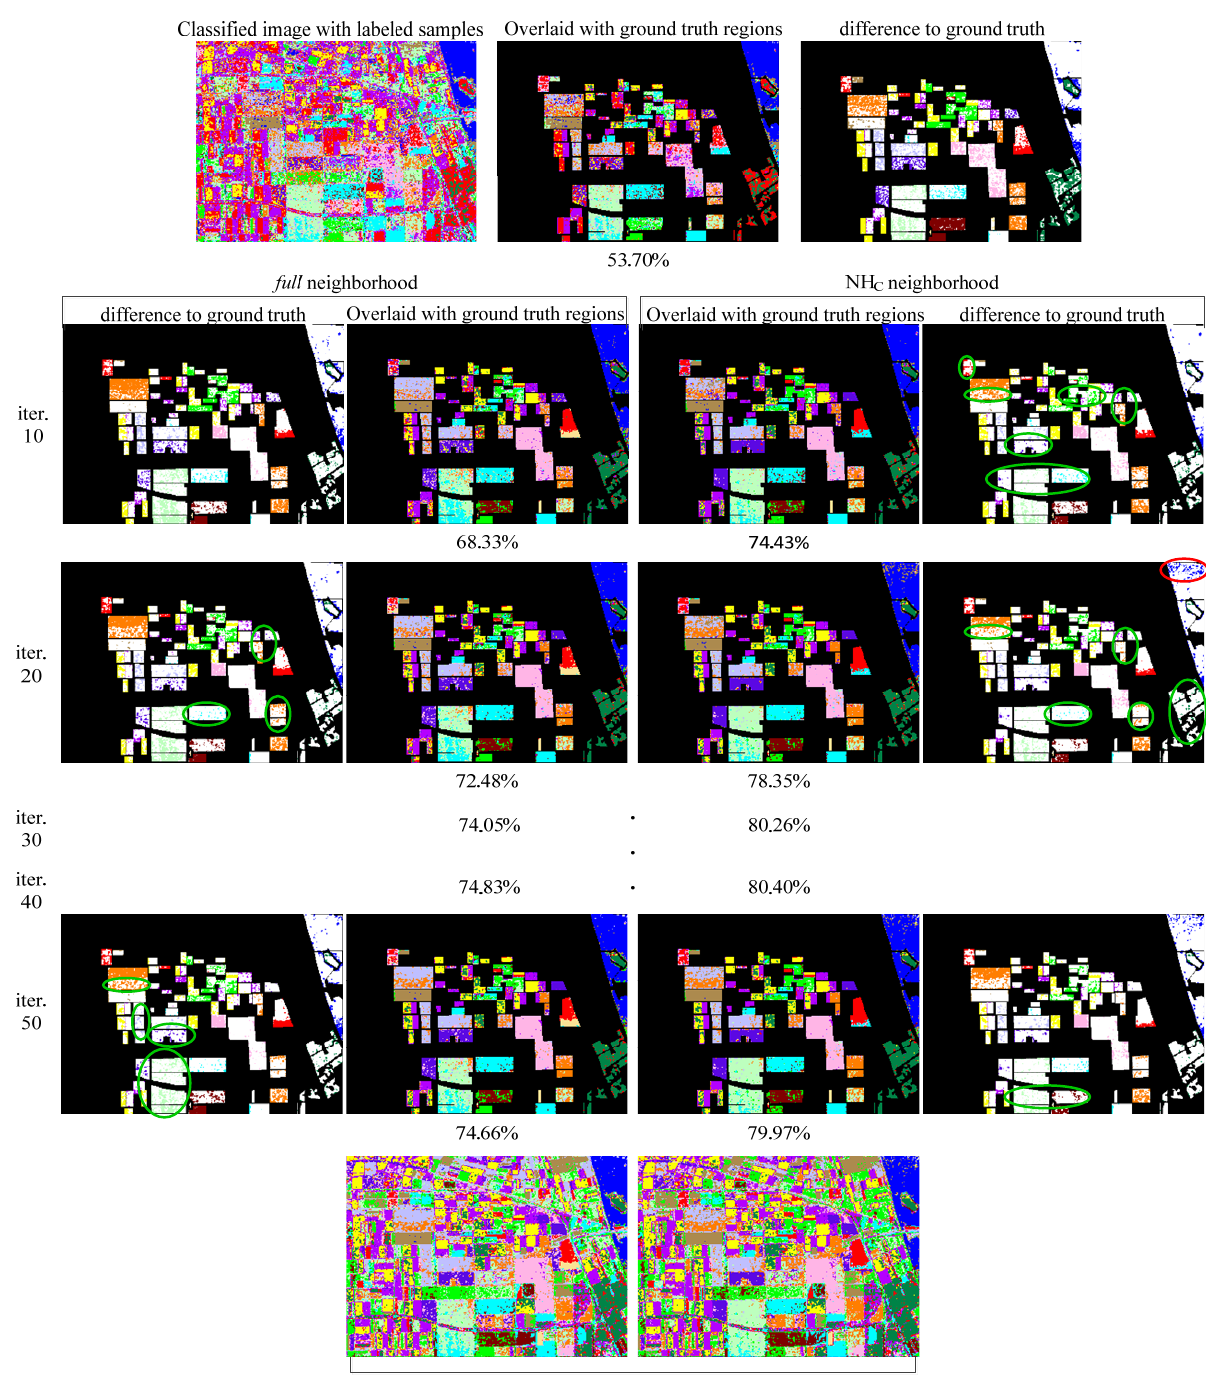
Figure 16. A sample set of classification maps obtained by different self-training iterations over an instance of labeled set T using Random Forest as the ensemble base classifier. 2 White color indicates a match between classification results and the ground truth. Green circles for results in the 10th iteration of the self-training (iter = 10) indicate difference among the two search neighborhoods, full and NH , compared to the initial results from the o labeled samples in the first row. For the following rows, the green and red circles indicate higher improvements or degradation, respectively, to the corresponding previous row. Percentages are the respective classification accuracies obtained per